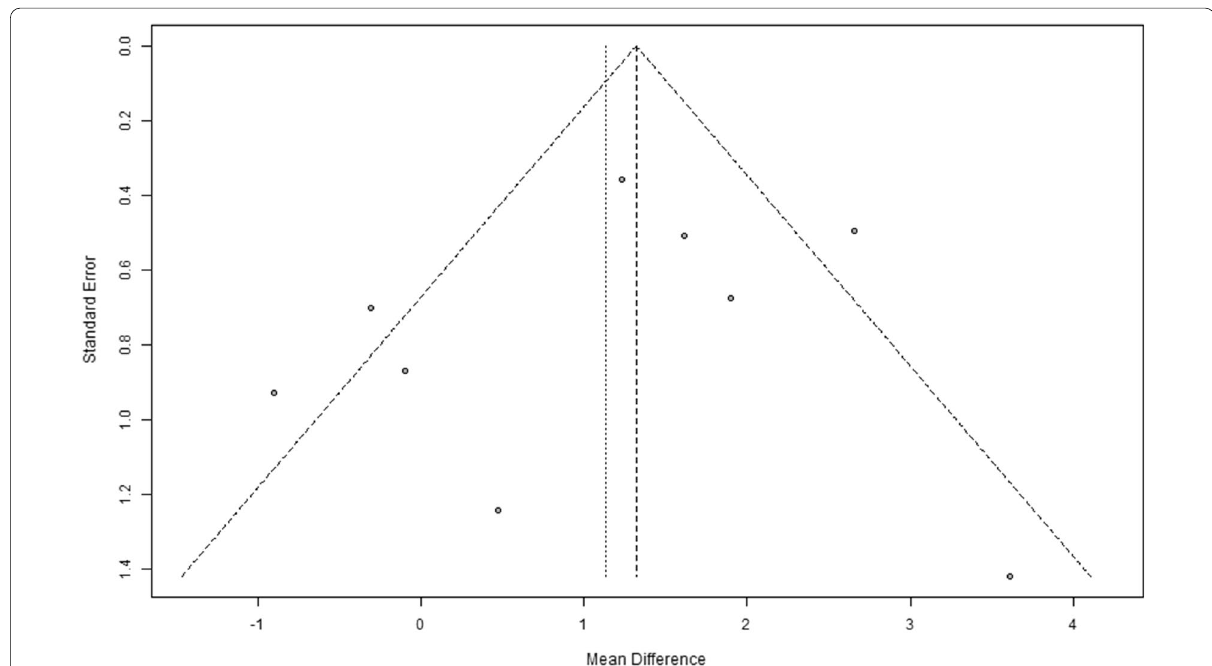
Fig. 10 Funnel plot for the original outcome (bone crest in